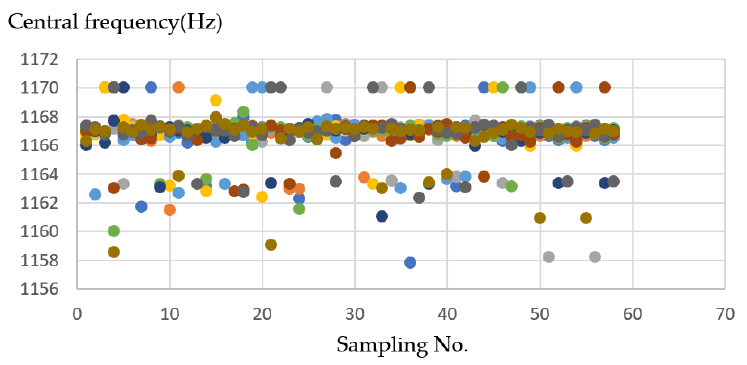
Figure 10. Ten sample frequency results from clustering by K-means for the XY axes.